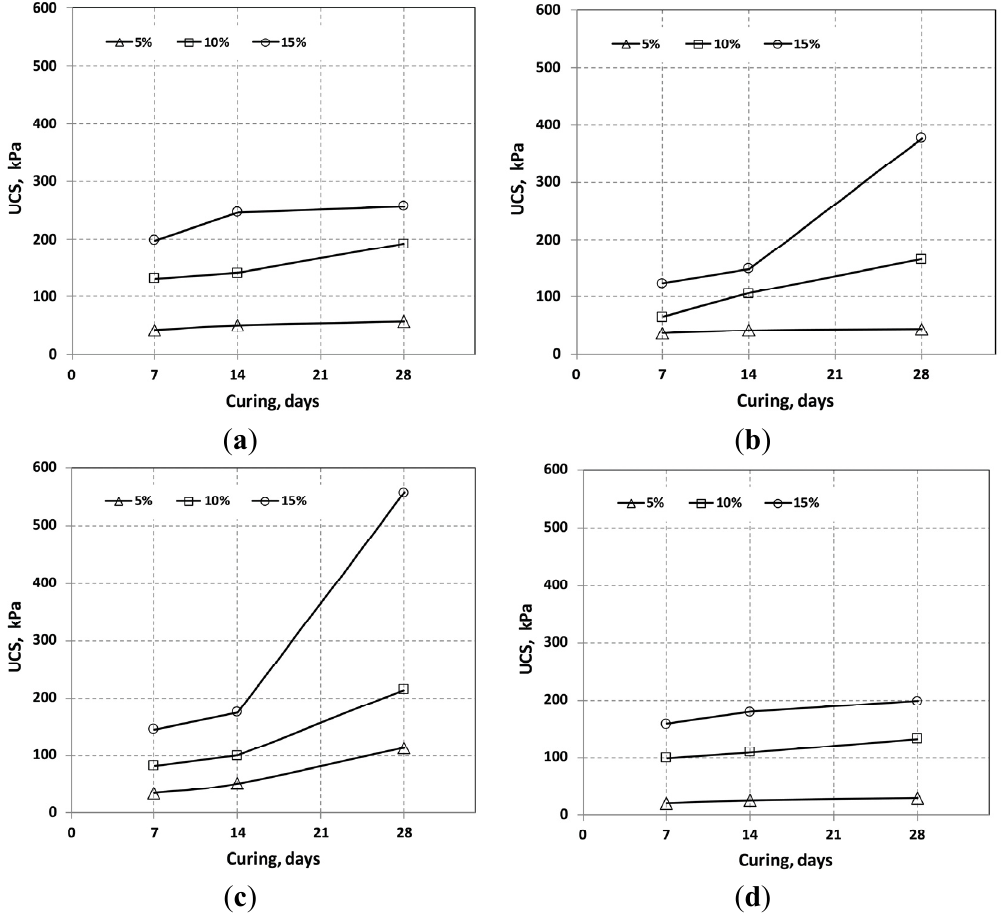
Figure 4. Relationship between curing days and unconfined compressive strength (UCS) of mixtures with admixtures. ( a ) OPC alone; ( b ) OPC + OSP; ( c ) OPC + SMS; ( d ) OPC +